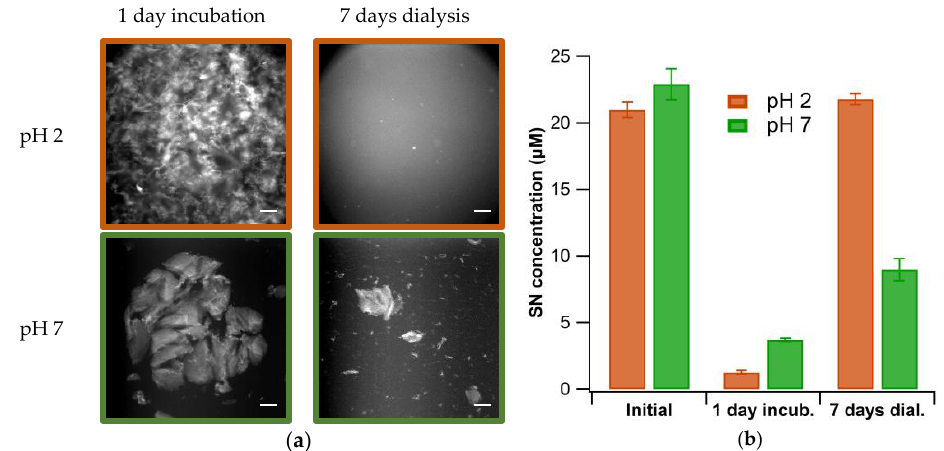
Figure 4. Dissociation of Gels vs. Plaques. ( a ) Images of ThT-stained lysozyme gels and plaques, induced by incubation of isolated fibrils at either pH 2 and 400 mM NaCl (top) or pH 7 and 100 mM NaCl (bottom). Images were taken after 1 day of incubation (left column) and subsequent to 7 days of dialysis at pH 2 and 0 salt (right column). ( b ) Quantification of fibrils in solution following centrifugation at 6000 g before incubation, after 1 day of incubation, and following 7 days of dialysis. Scale bar: 100 μm.